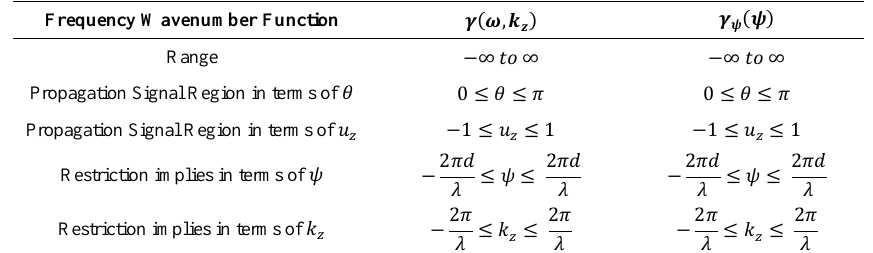
Table 4. Visible region of 𝜸(𝝎, 𝒌 𝒛 ) and 𝜸 𝝍 (𝝍) with respect to Frequency Wavenumber Function.